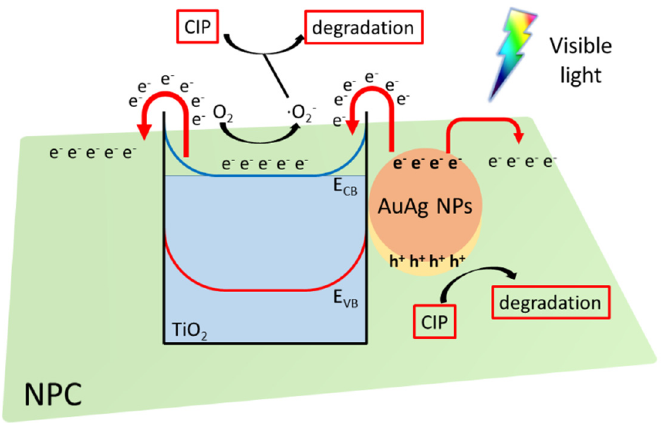
Figure 8. Schematic representation of the mechanism of degradation of CIP through the plasmonic hot-electron injection from AuAg NPs to the CB of TiO 2 and further charge-carrier separation in NPC shells.